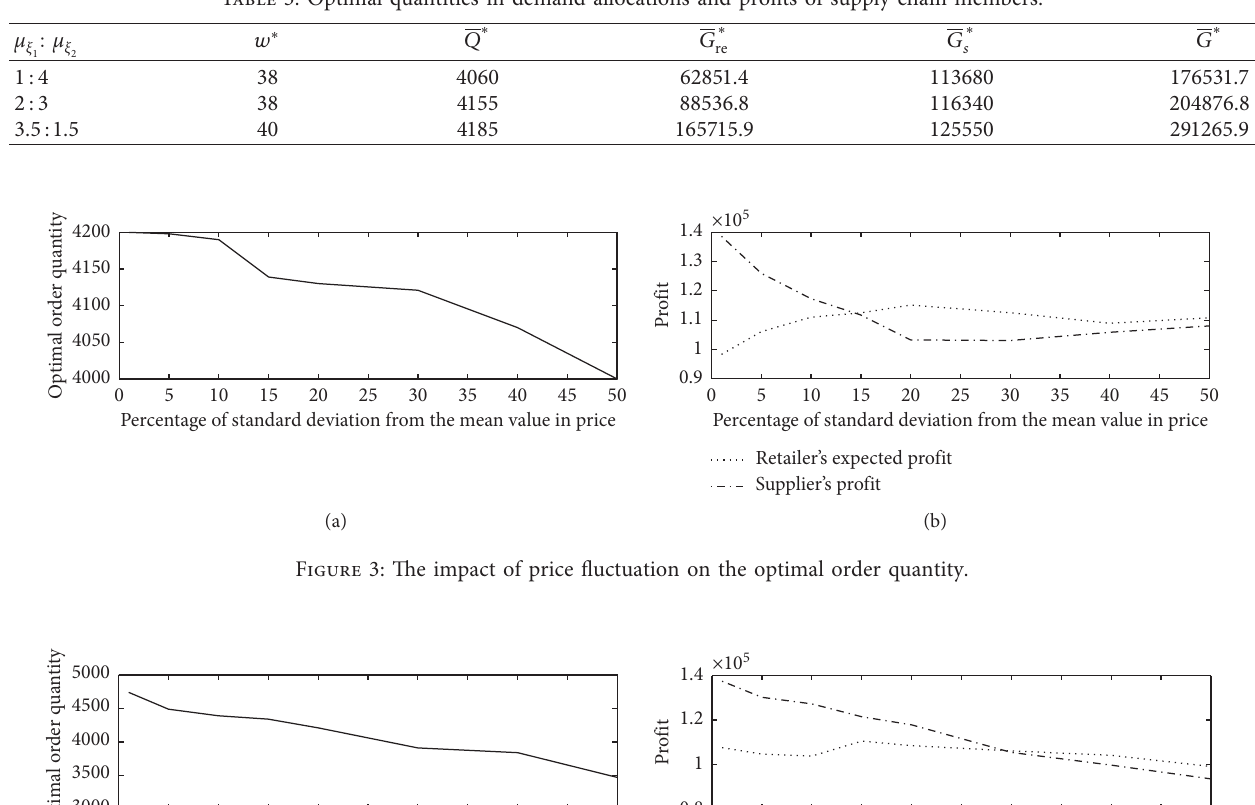
Table 3: Optimal quantities in demand allocations and profits of supply chain members.